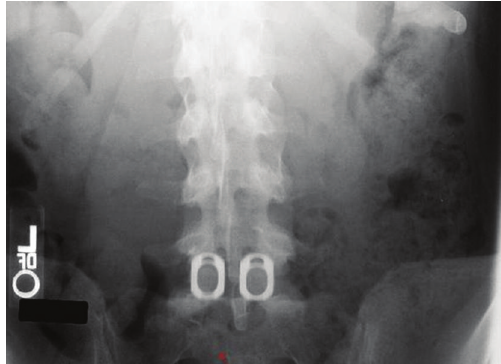
Figure 2: Wide Cage placement at L5-S1